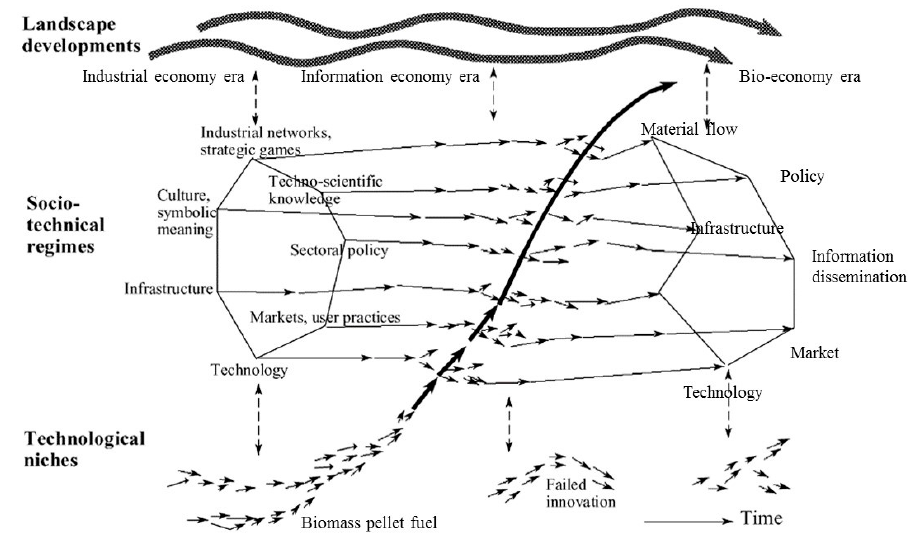
Figure 7. Multilevel perspective (MLP) of bioenergy development [19].